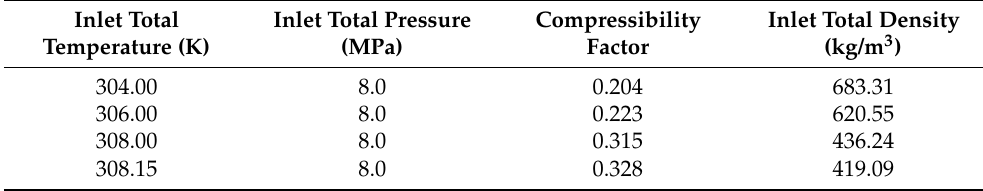
Table 5. Total density and compressibility factor at various inlet total temperatures.